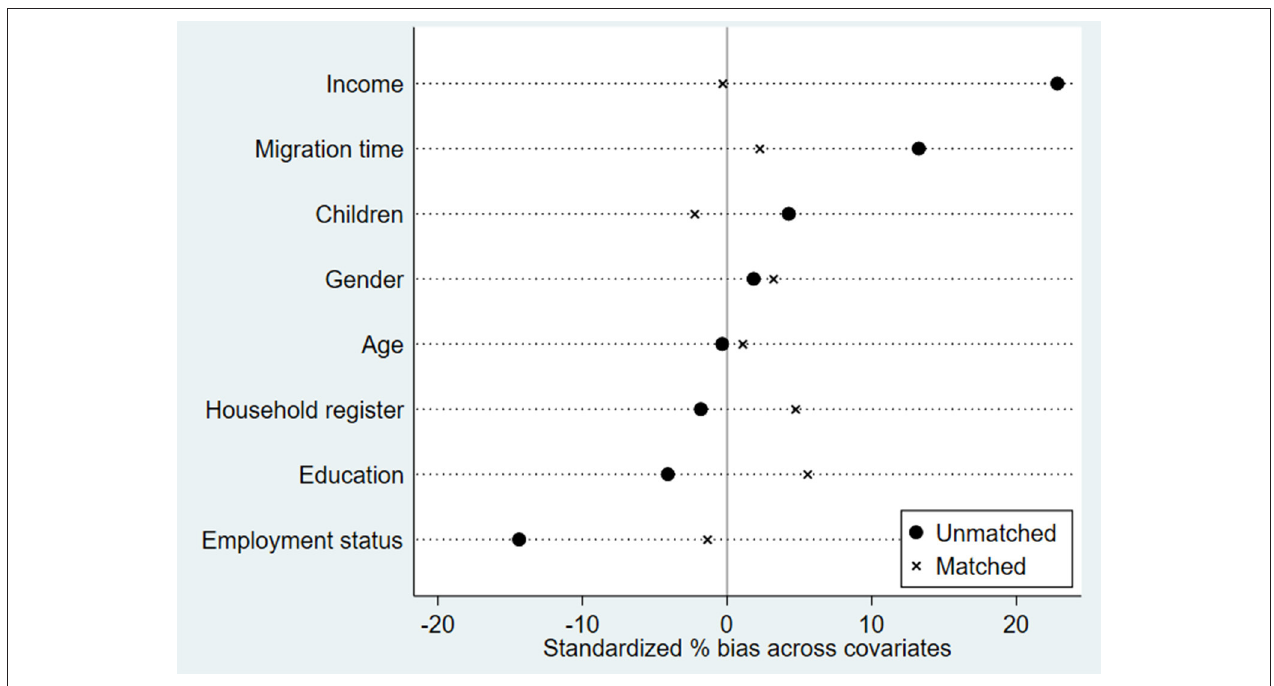
FIGURE 2 | Standardized bias before and after